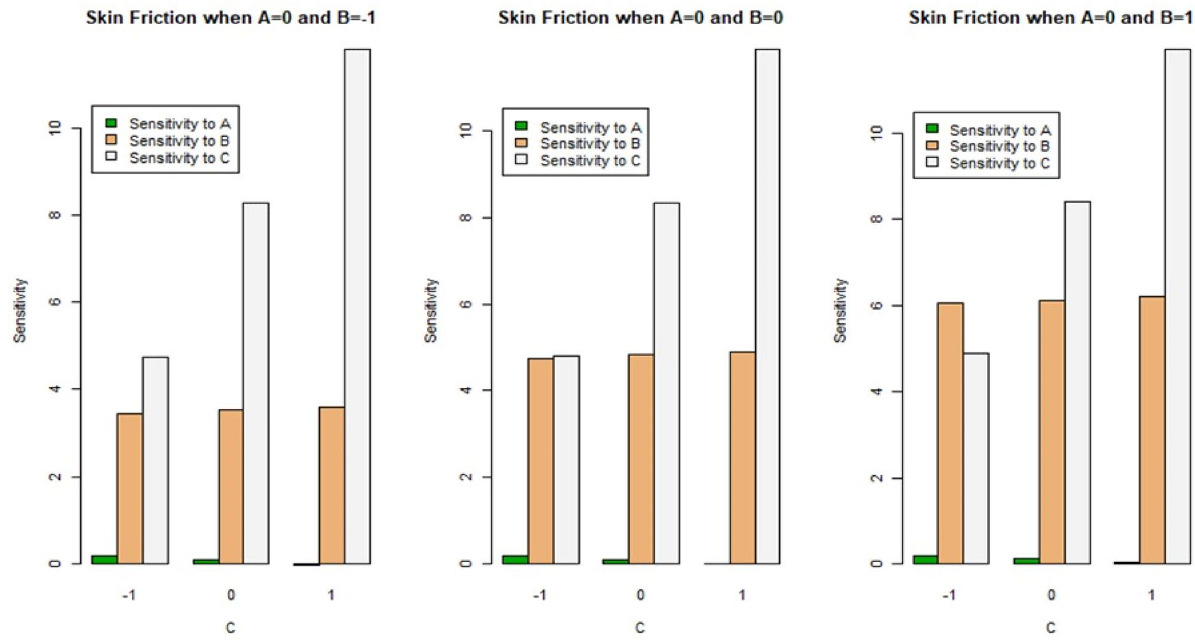
Figure 12. Bar chart representation of sensitivity analysis for C f √ Re x with A = 0 and all combinations of (B) and (C).